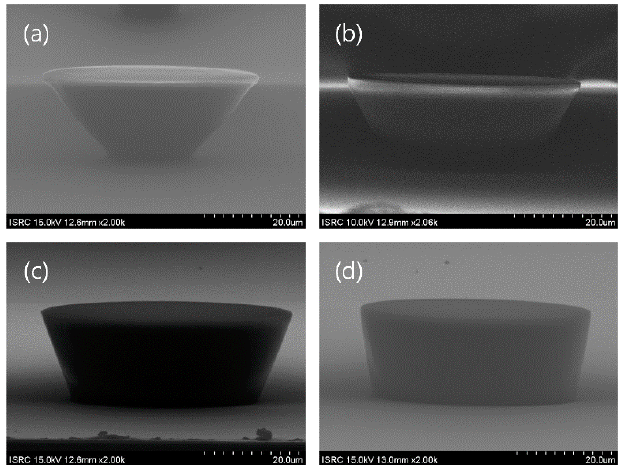
Figure 4. SEM images of the inclined sacrificial post under different exposure conditions. The height of the photoresist post was 20 μ m, and the pattern of the photomask was a circle with a diameter of 50 μ m. ( a ) A 160 μ m PET film was placed between the wafer and photomask, and the exposure time was 14 s at 25 mW/cm 2 . The angle of the resulting post was 50°, obtained by averaging 9 individual posts from five rounds of fabrication. ( b ) The same PET film was used, with an exposure time of 14 s. The measured angle was 63°. ( c ) Soft contact was used, the exposure time was 14 s, and the angle was 72°. ( d ) Hard contact was used, the exposure time was 14 s, and the angle was 83°.